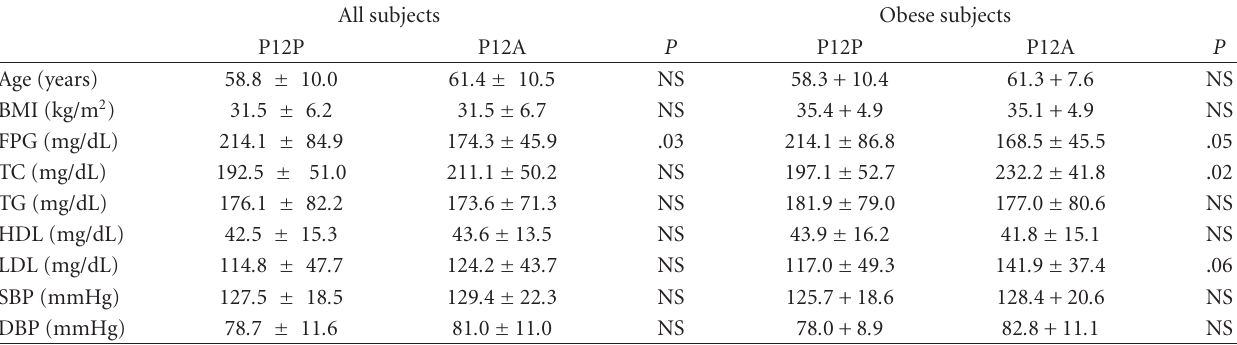
Table 3: Biochemical and anthropometrical parameters for subjects based on PPAR γ 2 genotype. The chi-square test was performed for